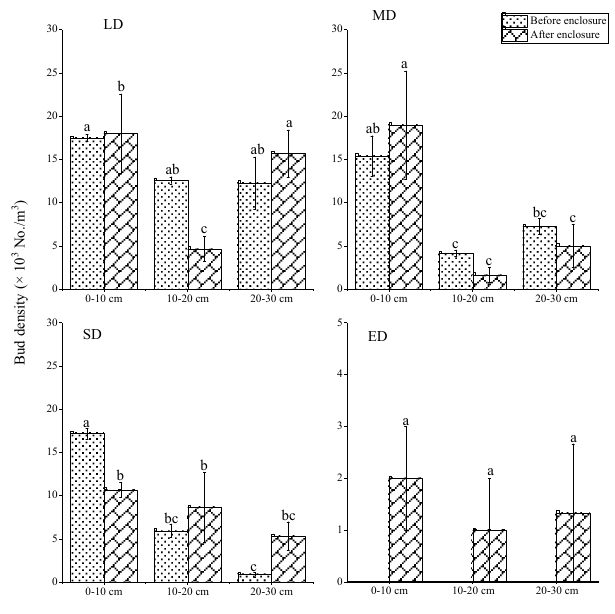
Figure 4. Variation characteristics of bud bank distribution in different soil layers. LD: light desertified grassland; MD: moderate desertified grassland; SD: severe desertified grassland; and ED: extreme desertified grassland. Data with different letters in the same column indicate significant differences at the 0.05 level.